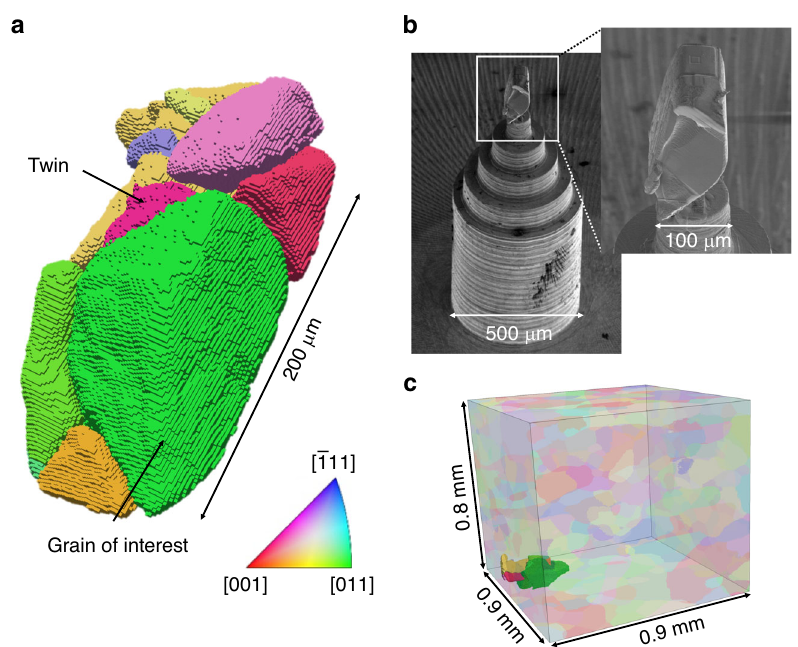
Fig. 3 Extraction and DCT Characterization. ( a ) DCT reconstruction of extracted specimen, colored by IPF. ( b ) SEM images of extracted specimen mounted upon a brass pedestal. ( c ) Location of extracted specimen relative to the HEDM reconstruction of the gauge section of the sample.